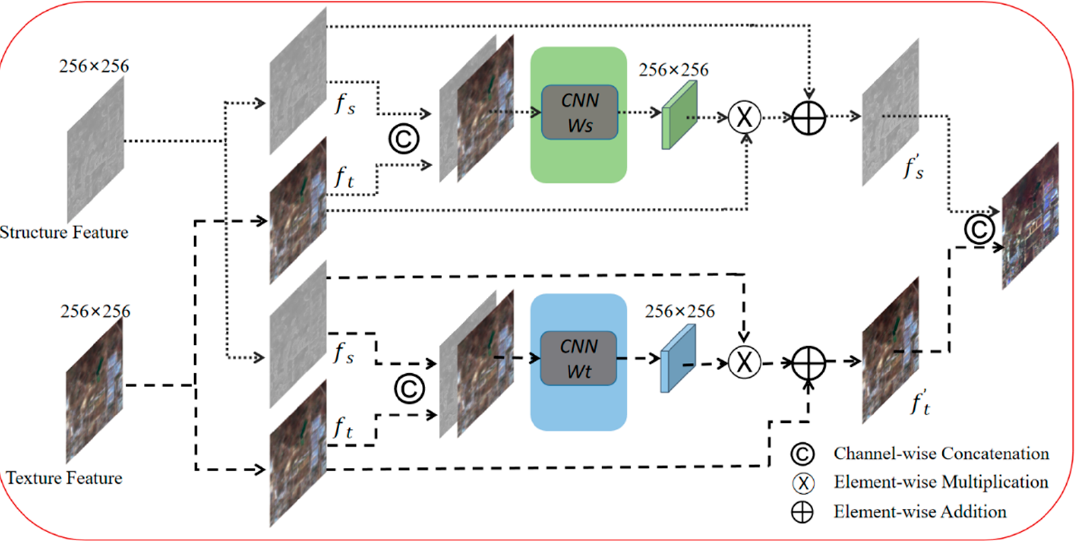
Figure 3. Structural diagram of the Bi-GFF module, in which deep fusion of texture and structure features is performed.